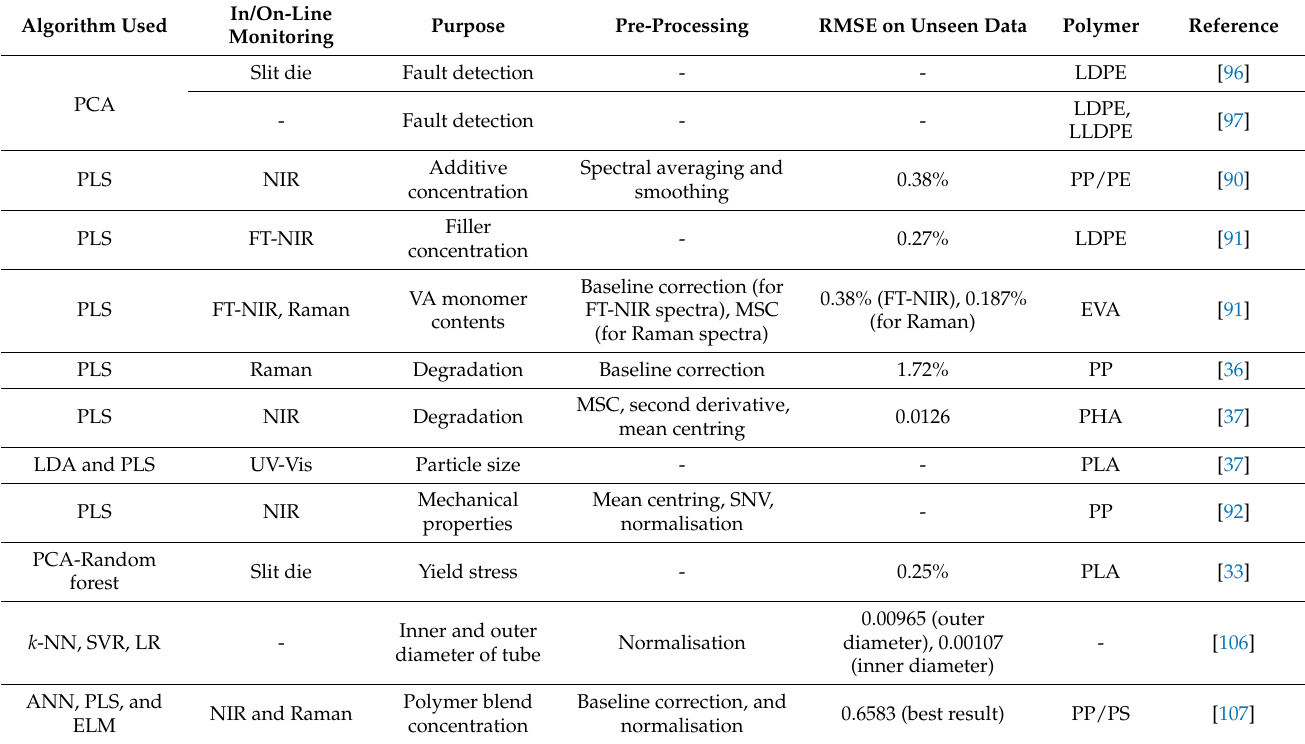
Table 4. Application of machine learning for polymer HME